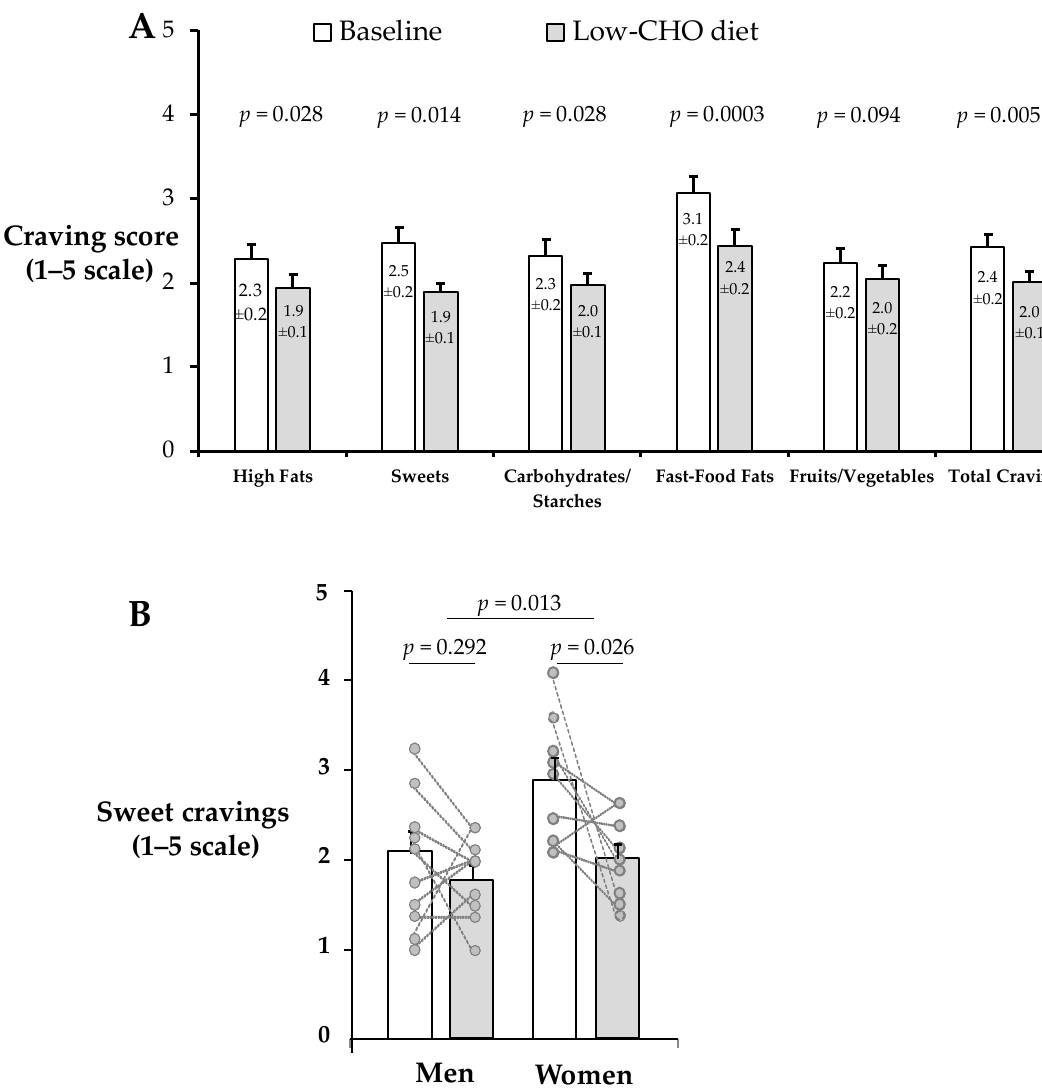
Figure 3. Mean craving scores over time ( A ), and sweet cravings by sex ( B ). Data are mean ± SE and reported for N = 19 subjects (10 men and 9 women) who had complete cravings data. A score of 1 = never and 5 = always/almost every day. All cravings subcategories except fruits/vegetables were significantly reduced in the total sample. Only sweet cravings showed a significant main effect of sex. All significance tests were two-tailed.